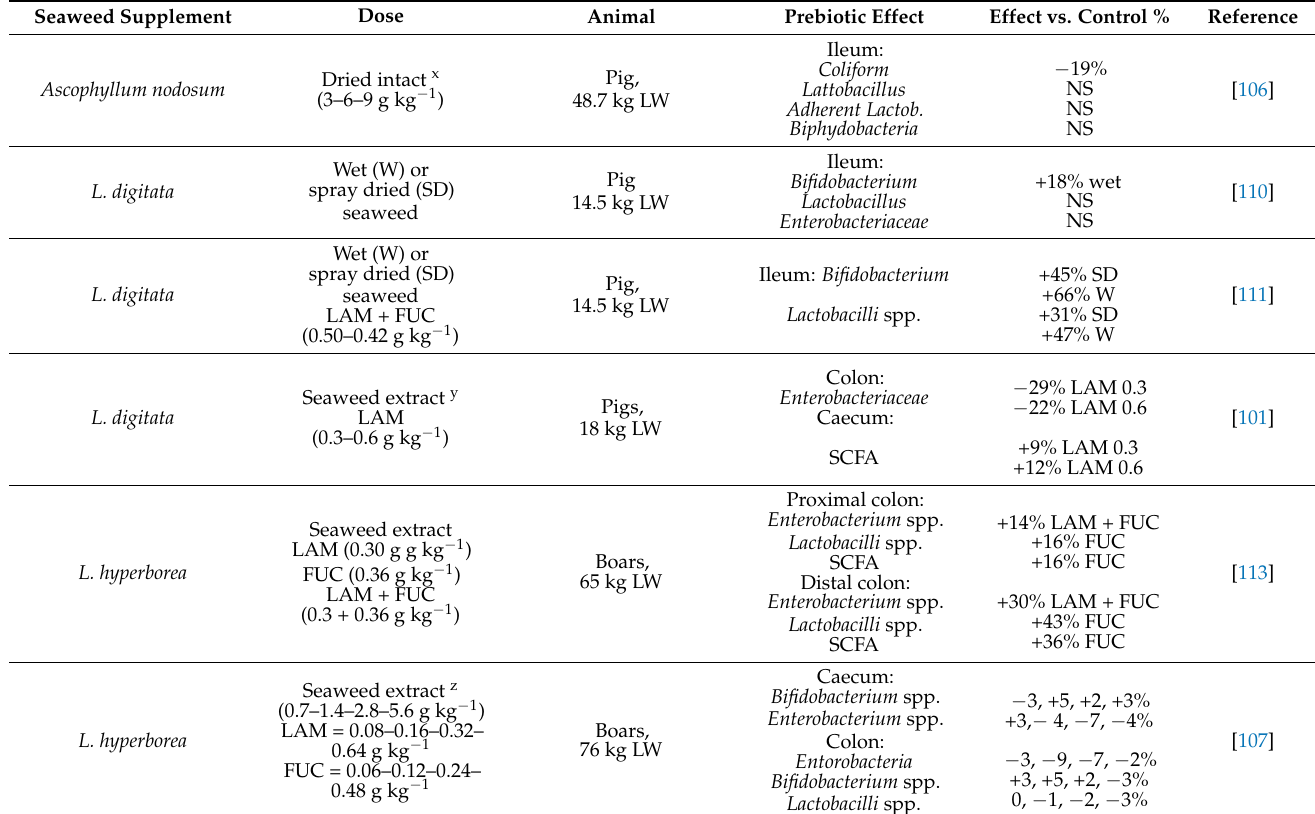
Table 5. Prebiotic effects of seaweed in growing finishing swine.